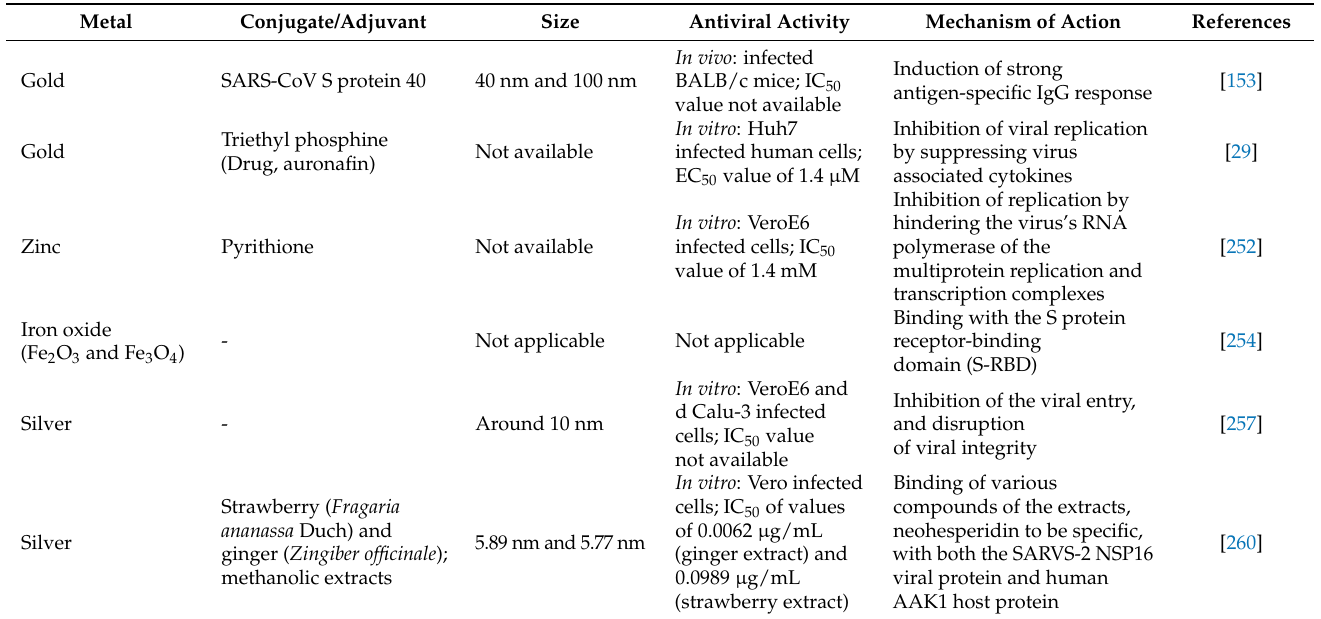
Table 6. Antiviral activity of metal NPs and their functionalized counterparts against COVID 19/SARS-CoV-2 and possible mechanisms of